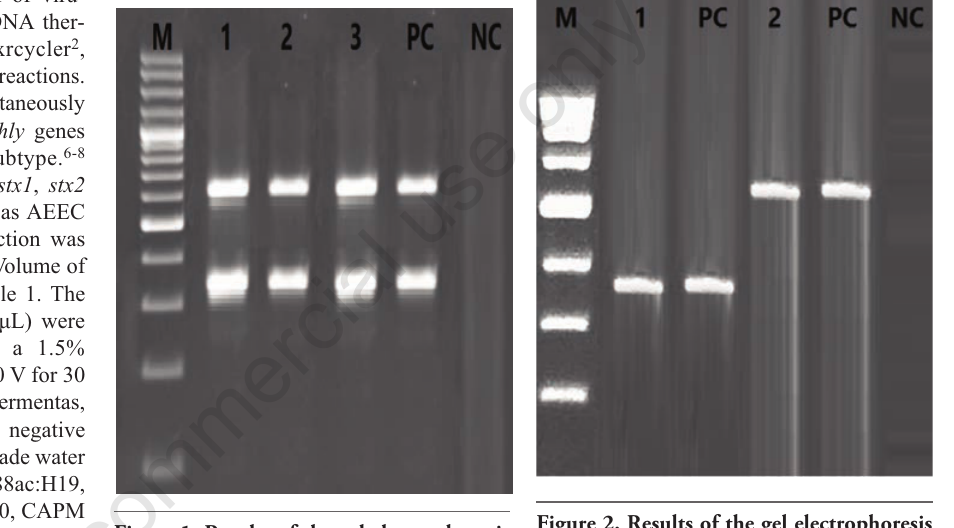
Figure 1. Results of the gel electrophoresis for virulence factors. M: 100 bp ladder, 1- 3: Positive samples for stx1 (366 bp) and eaeA (629 bp) genes, PC: Positive control and NC: Negative control.